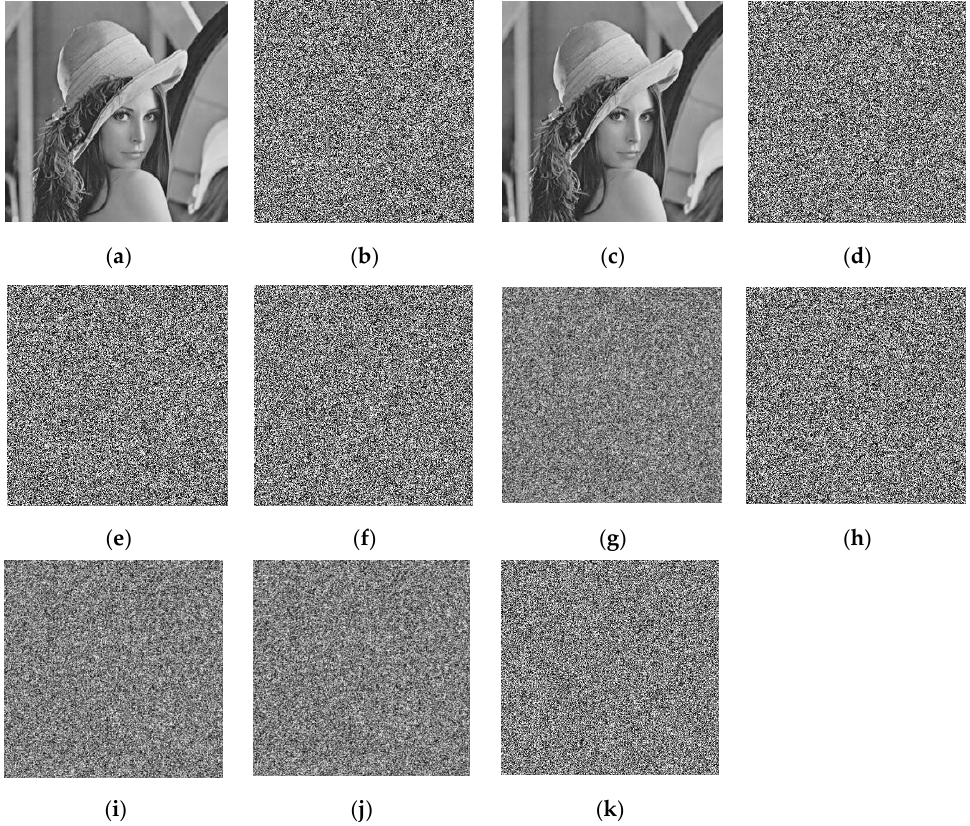
Figure 4. ( a ) ” Lena ” image ; ( b ) cipher image (initial encryption key); ( c ) decrypted image